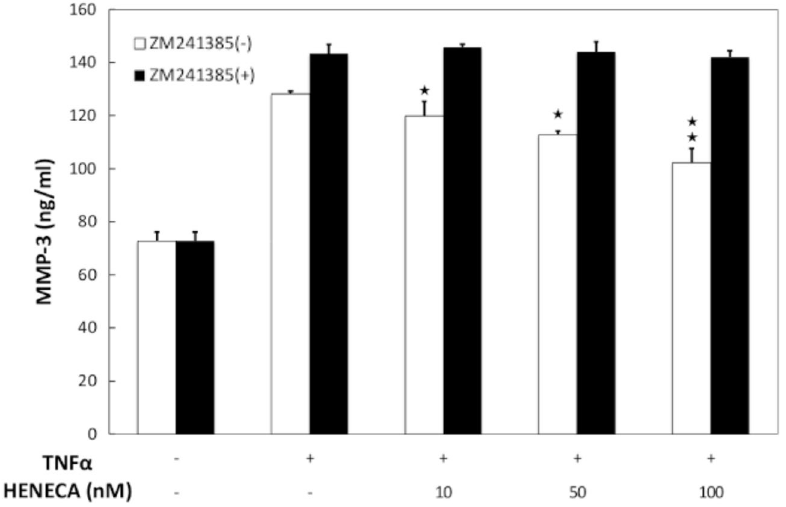
Figure 4. Stimulation of A 2A AdoRs reduced the basal and TNFα-induced MMP-3 release by MH7A cells. Activation of A 2A receptors suppressed TNFα-induced MMP-3 production by MH7A cells. MH7A cells were incubated for 24 h with TNFα (25 pg/ml) with or without the indicated concentrations of HENECA